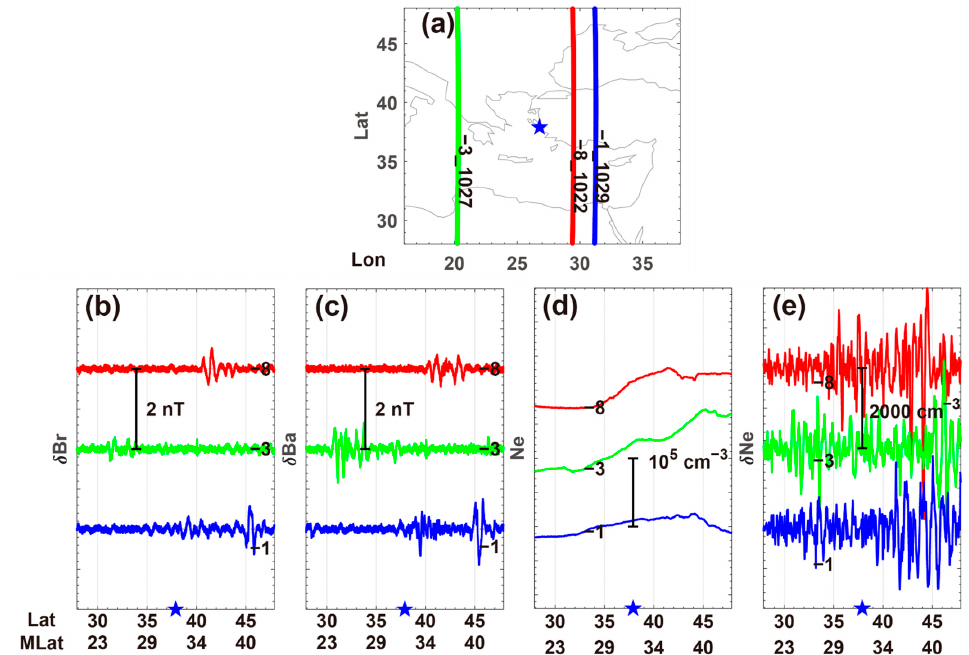
Figure A2. Remaining magnetic disturbances (LT~02) after removing the main influences of space weather events. ( a ) Swarm B orbits with magnetic disturbances in the range of 10° latitude by 10° longitude centered on the M7.0 earthquake. Annotations in panel ( a ) show time differences ( Δ T in days) and dates (mmdd) of each orbit; ( b , c ) present the residual magnetic field in Br and Ba components; ( d ) original Ne; and ( e ) residual Ne. The blue star indicates the epicenter.